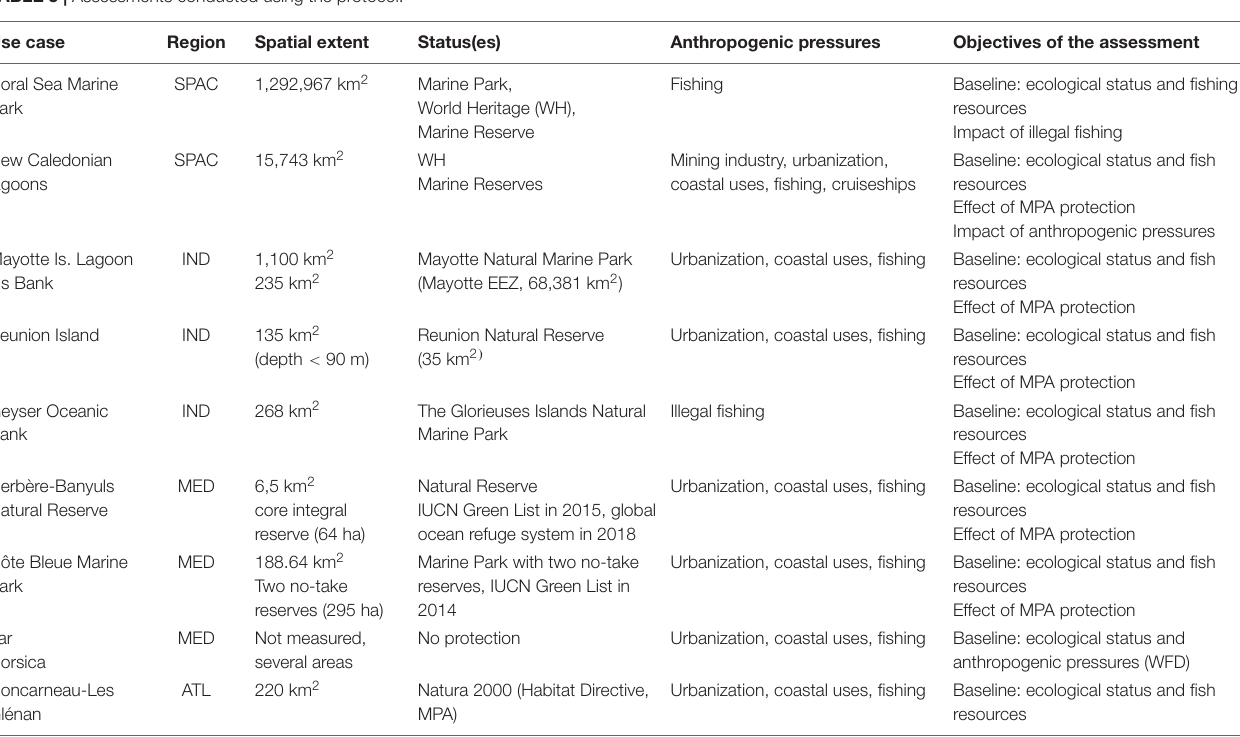
WFD stands for Water Framework Directive (EU 2000). Baseline stands for Baseline assessment. SPAC, Southwest Pacific Ocean; IND, Indian Ocean; MED, Northwestern Mediterranean Sea; ATL, Northeast Atlantic Ocean.